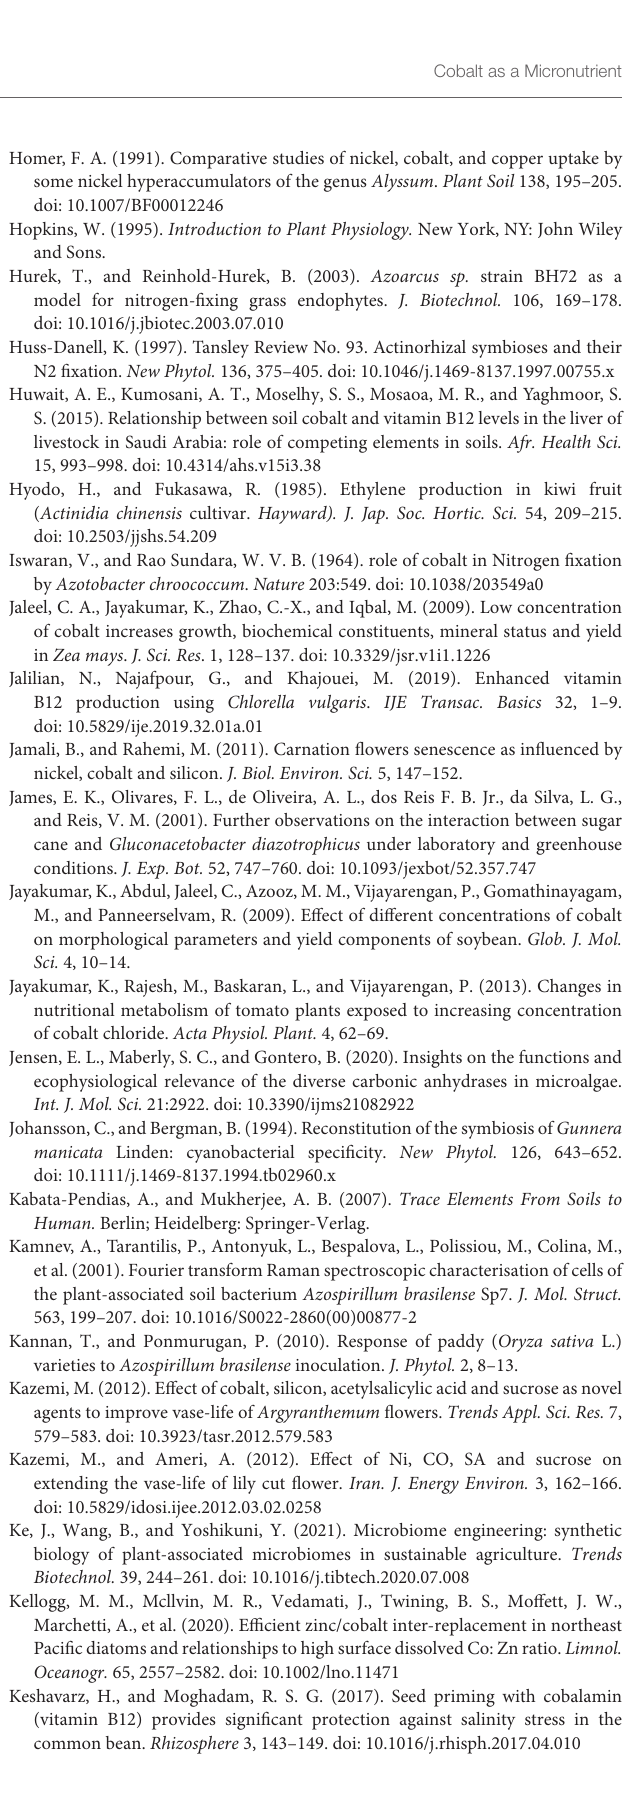
Frontiers in Plant Science |